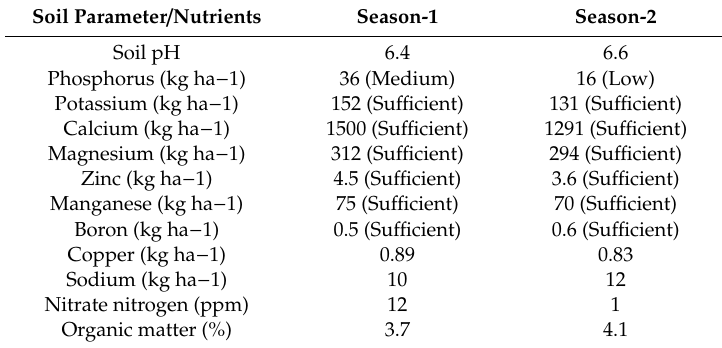
Table 1. Results of soil tests conducted before planting in season-1 and season-2. Average values for various soil parameters / nutrients are reported for season-1 and season-2. Low, medium, and su ffi cient indicate soil nutrient status provided in the soil test